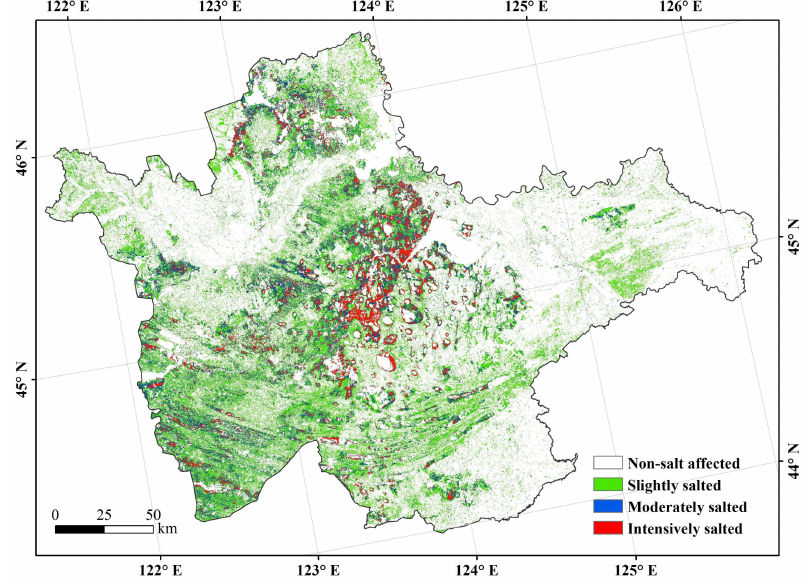
Figure 2. Distributions of soil salinity in the west